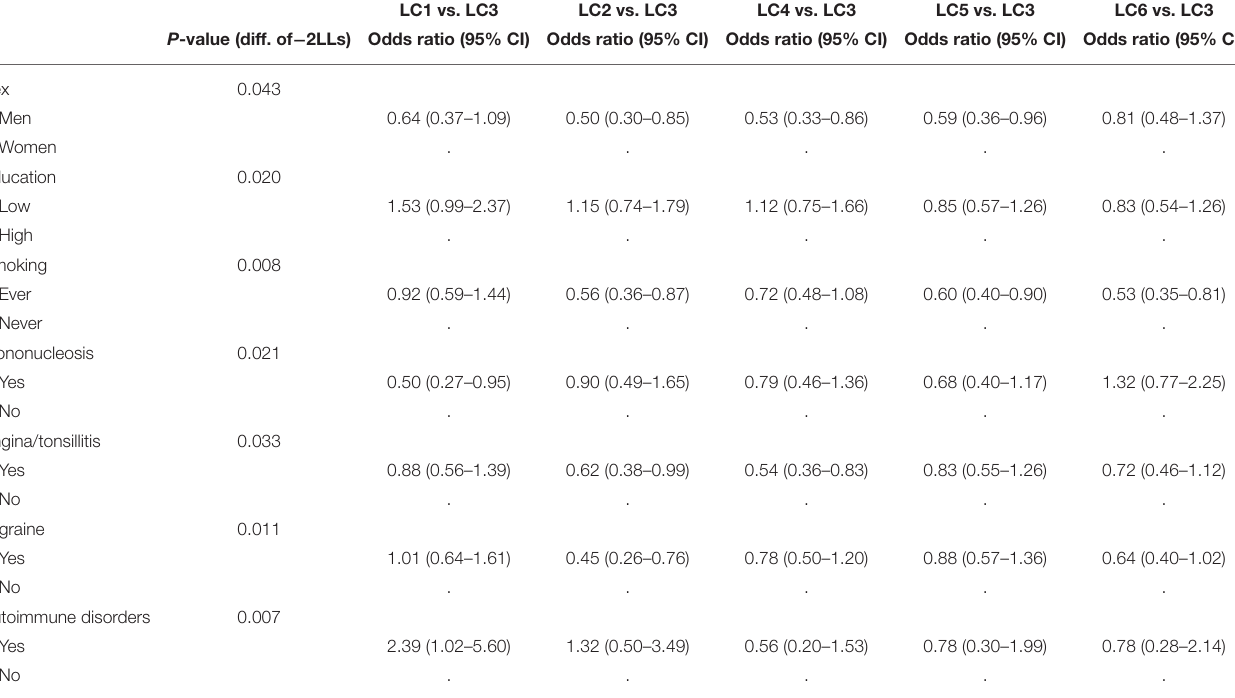
TABLE 4 | Multinomial logistic regression of latent classes on selected predictors, after backward selection procedure; category denoted by a dot is the reference category; n =